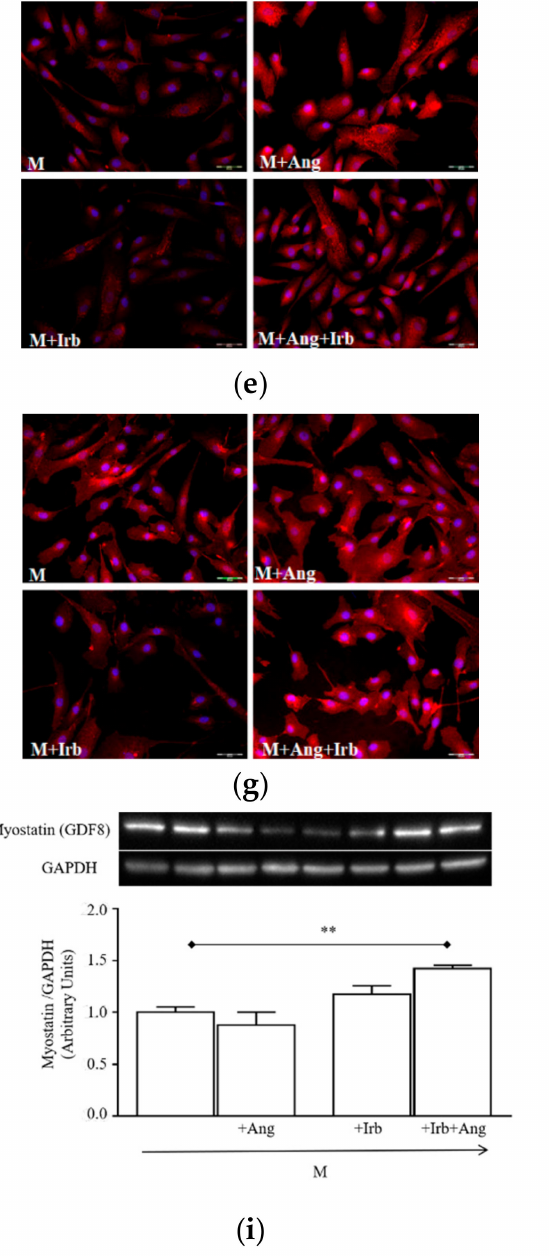
Figure 4. E ff ect of sub-chronic conditioning with Ang on hSC-size and myofibroblast markers: ( a ) Representative photomicrographs of cells labelled with Alexa Fluor (red) and DAPI (blue); ( b ) Values of cell cross-sectional areas (mean ± SEM) evaluated blind by two researchers using the drawing function of ImageJ software; immunolabelling and relative quantifications of α -smooth muscle actin ( c , d ), transgelin-2 ( e , f ), and β -catenin ( g , h ). Target proteins are stained in red, cell nuclei are in blue (DAPI). Quantifications of protein expression were performed blind by two researchers. All image magnifications are 20 × ; ( i ) immunoblotting (top) of myostatin detected in protein extracts of cultured hSCs and densitometric quantification (bottom). * p < 0.05, ** p < 0.01 and *** p < 0.001. In this experiment, hSCs were cultured for 24 h in a standard medium (M) or M supplemented with 100 nM Ang (M + Ang), or 1 µ M irbesartan (M + Irb) or 1 µ M Irb plus 100 nM Ang (M + Irb +